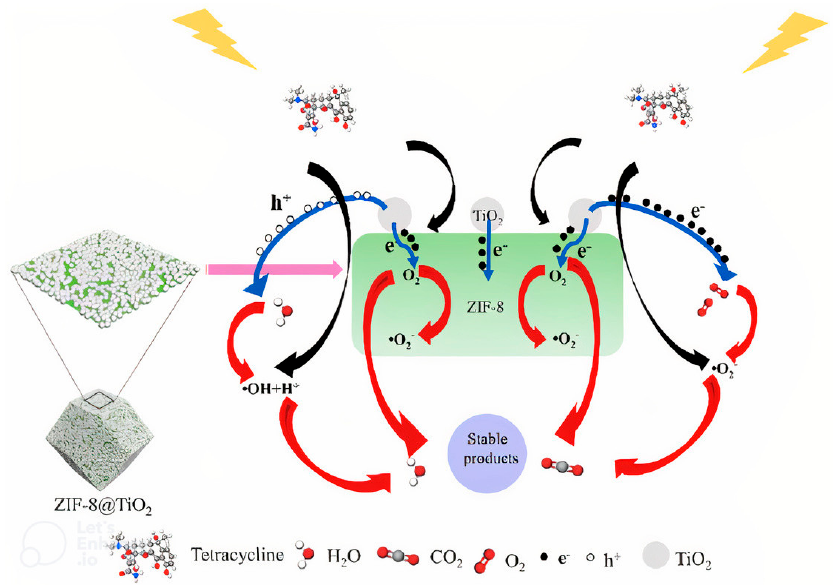
Figure 9. Mechanism of photocatalysis, reproduced with permission from [208]. Copyright Elsevier, 2020.